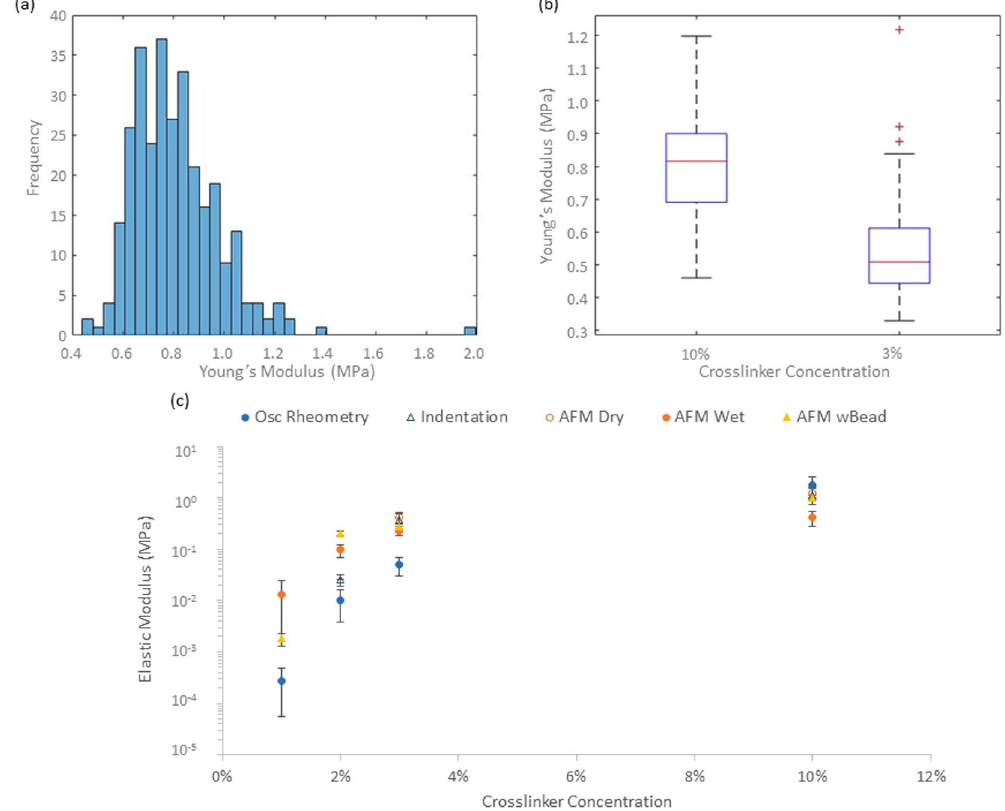
Figure 3. ( a ) Representative dry AFM histogram showing the spread in moduli value over three 5 × 5 μ m locations with 100 indentations per location on a 10% crosslinker PDMS sample, ( b ) box and whisker plots showing the Young’s moduli obtained across the range of PDMS samples tested by dry AFM and ( c ) comparison of the bulk and local mechanical characterisation of the PDMS samples tested. All AFM experiments were conducted with an indentation depth of between 500 and 1000 nm and each curve was done over 1 s. AFM experiments were conducted on three different samples for each formulation and each sample tested in three different location with 100 indentations done on a 5 by 5 μ m